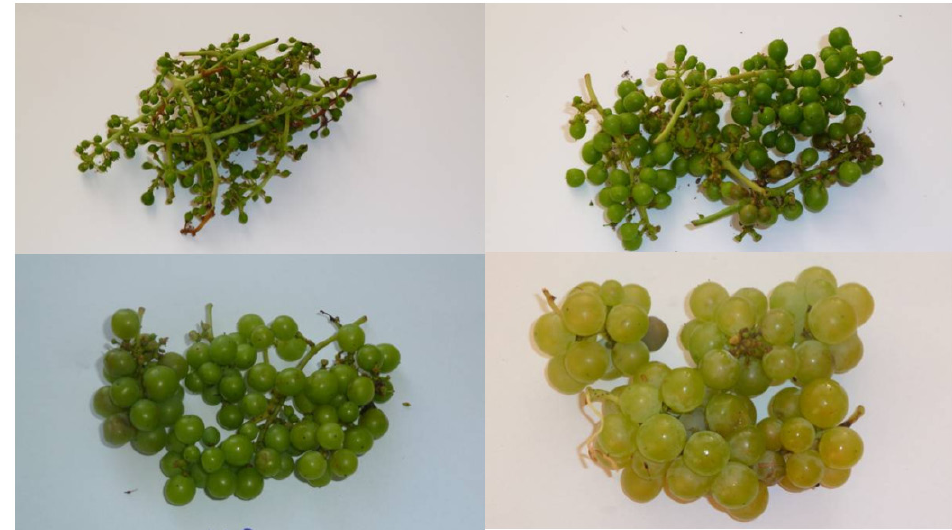
Figure 1. Grapes of Muscat Ottonel variety picked on the following days: 26. 6. 2011, 10. 7. 2011, 7. 8. 2011, and 18. 9.